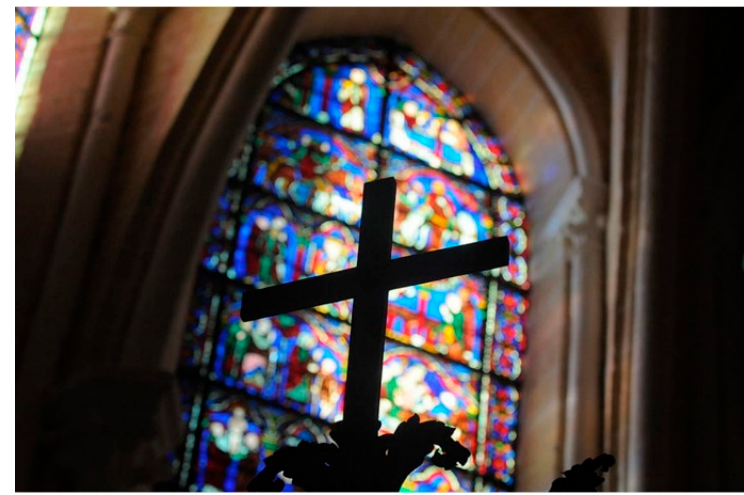
Figure A6. Stimulus Image for the God’s Creation Message.